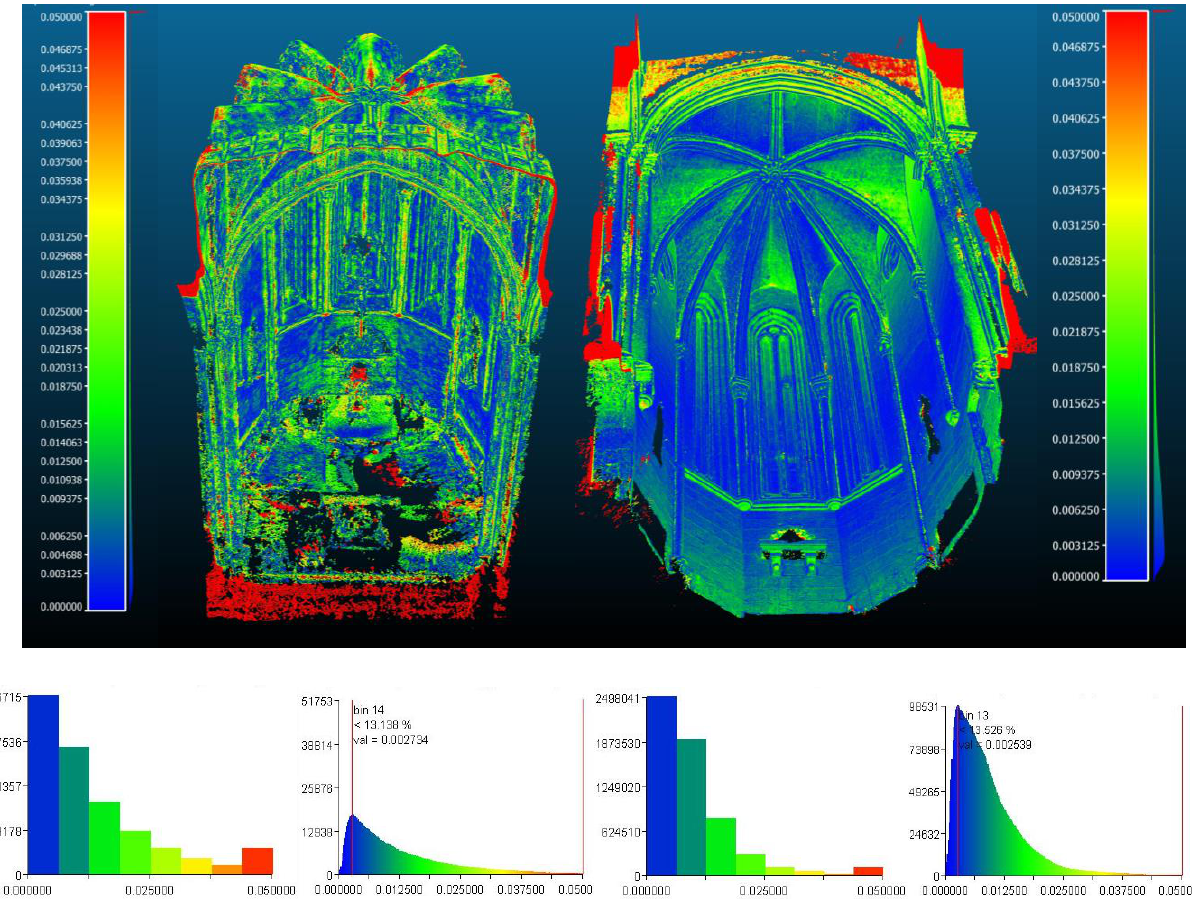
Figure 21. NCTech iSTAR (left) and Canon 550 D SRL (right) point cloud deviation compared to FARO Focus 3D